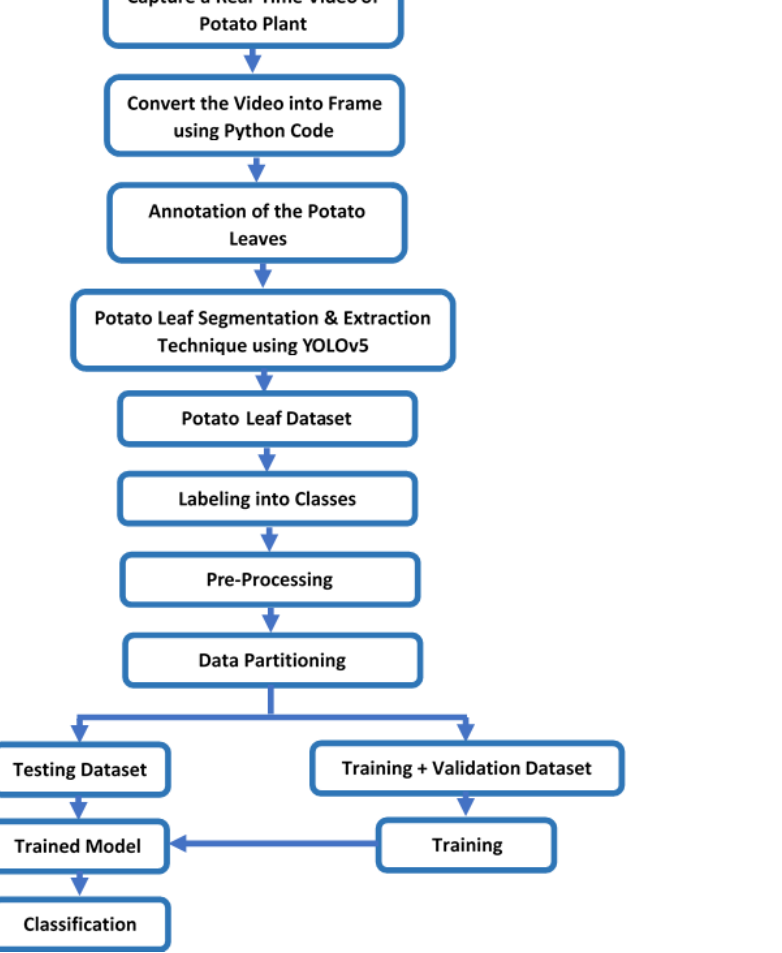
Figure 1. A flowchart of the proposed model.